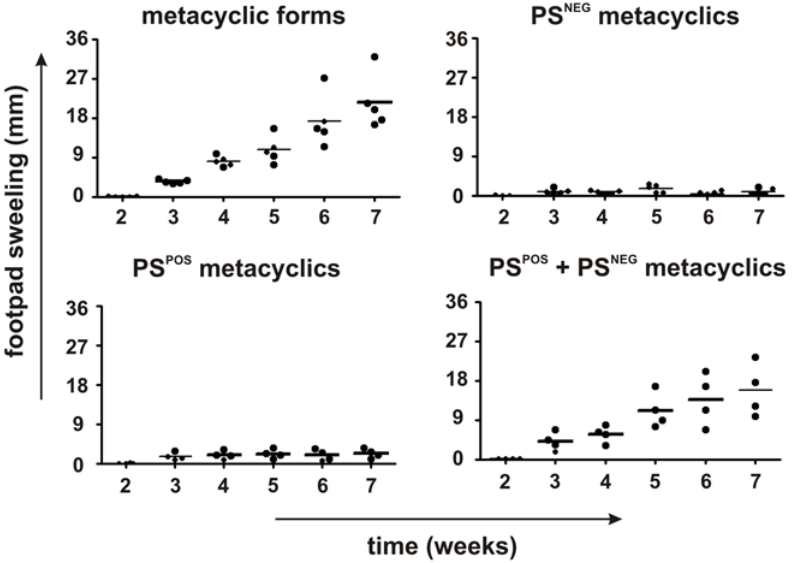
Figure 4. Purified PS POS promastigotes are required for the invivo infectivity of PS NEG forms. Footpad swelling in BALB/c mice inoculated with 10 5 metacyclic promastigotes as well as the same number of sorted PS POS , PS NEG and PS POS + PS NEG (reconstituted at a 1:1 ratio) population of promastigotes. Each dot represents a single animal and the horizontal bar represents the median lesion size of each group.